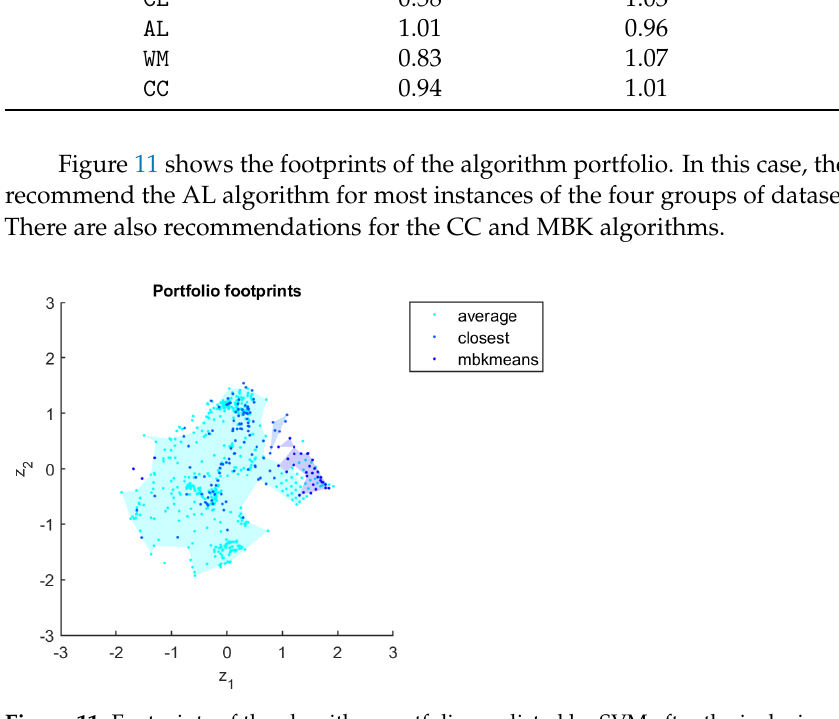
Figure 11. Footprints of the algorithm portfolio predicted by SVM after the inclusion of real